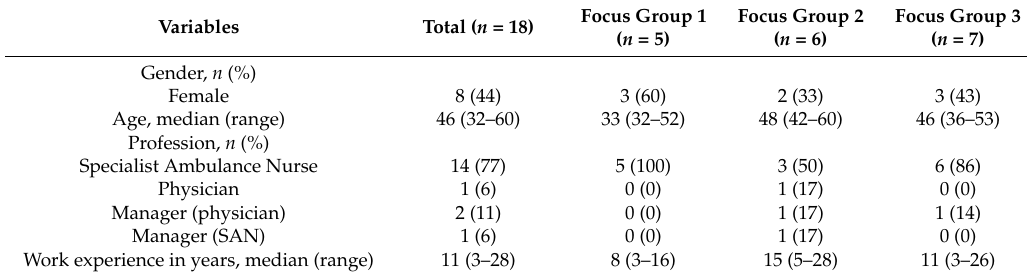
Table 1. Demographic data of the participants in the study, n =